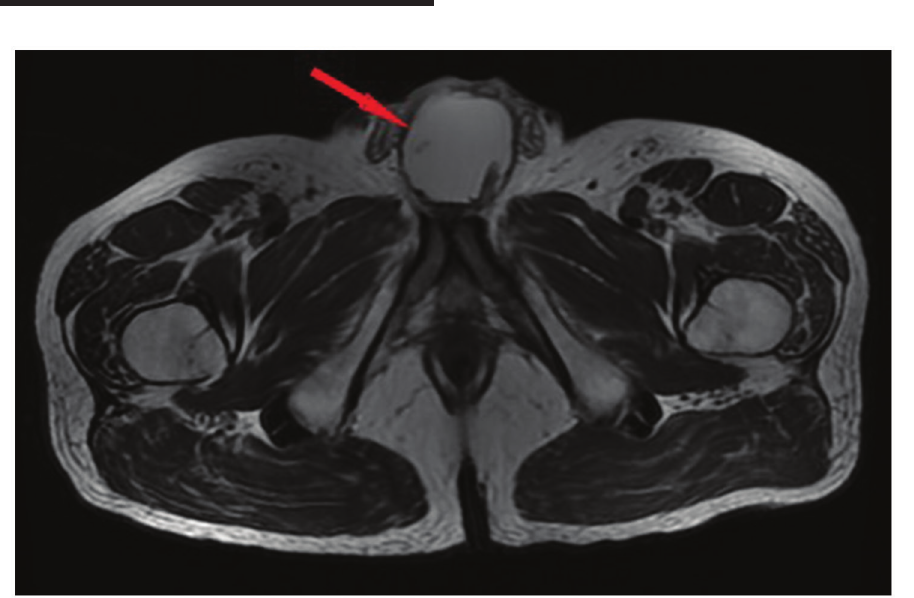
Figure 4. T2-weighted images showing a round-like abscess in the cavernous body of the penis root.